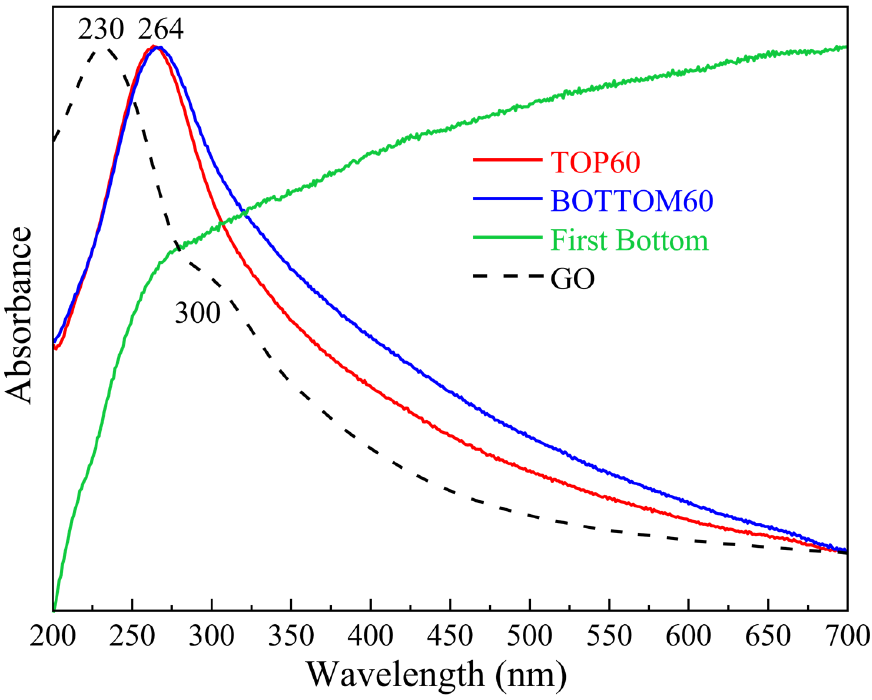
Figure 4. UV-vis normalized extinction/absorption spectra of the GNPs samples of TOP60, BOT- Figure 4. UV ‐ vis normalized extinction/absorption spectra of the GNPs samples of TOP60, TOM60, First BOTTOM and Graphene Oxide BOTTOM60, First BOTTOM and Graphene Oxide (GO).